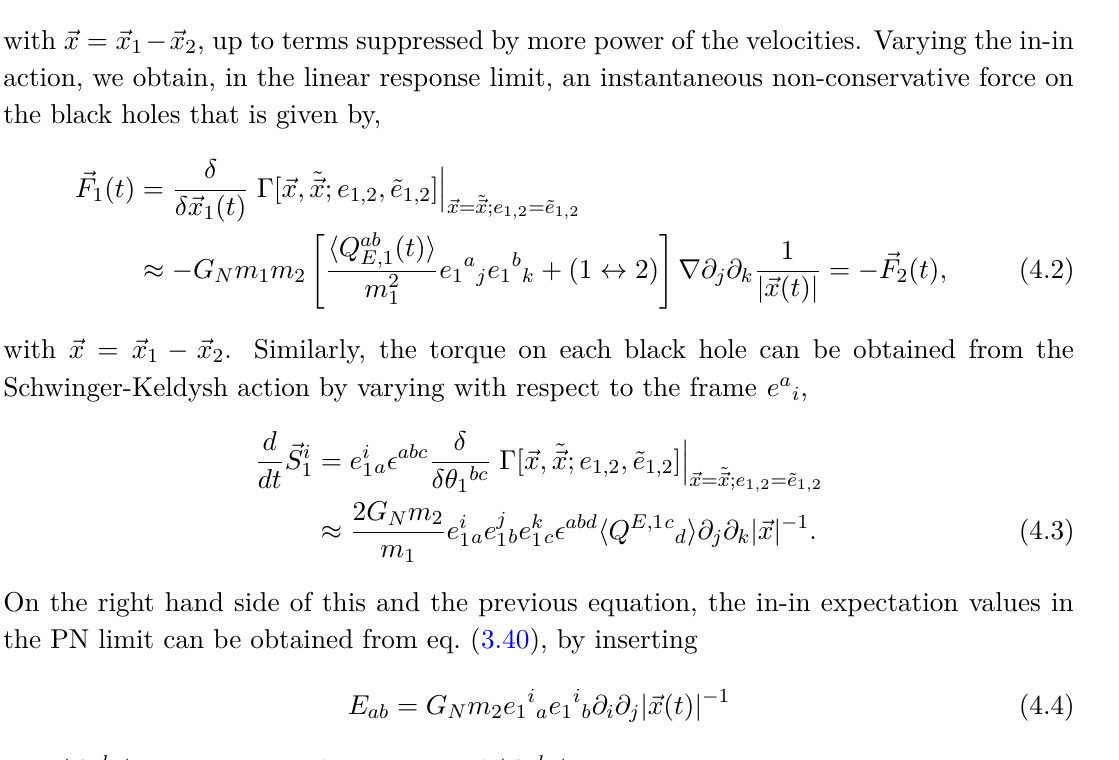
Figure 1 . Potential exchange diagrams that contribute to the two-particle action S int . In (a) the particles interact through the minimal gravitational interaction. Figure (b) is the term in S int generated by the quadrupole couplings of particle 1 (a similar diagram with 1 ↔ 2 has been